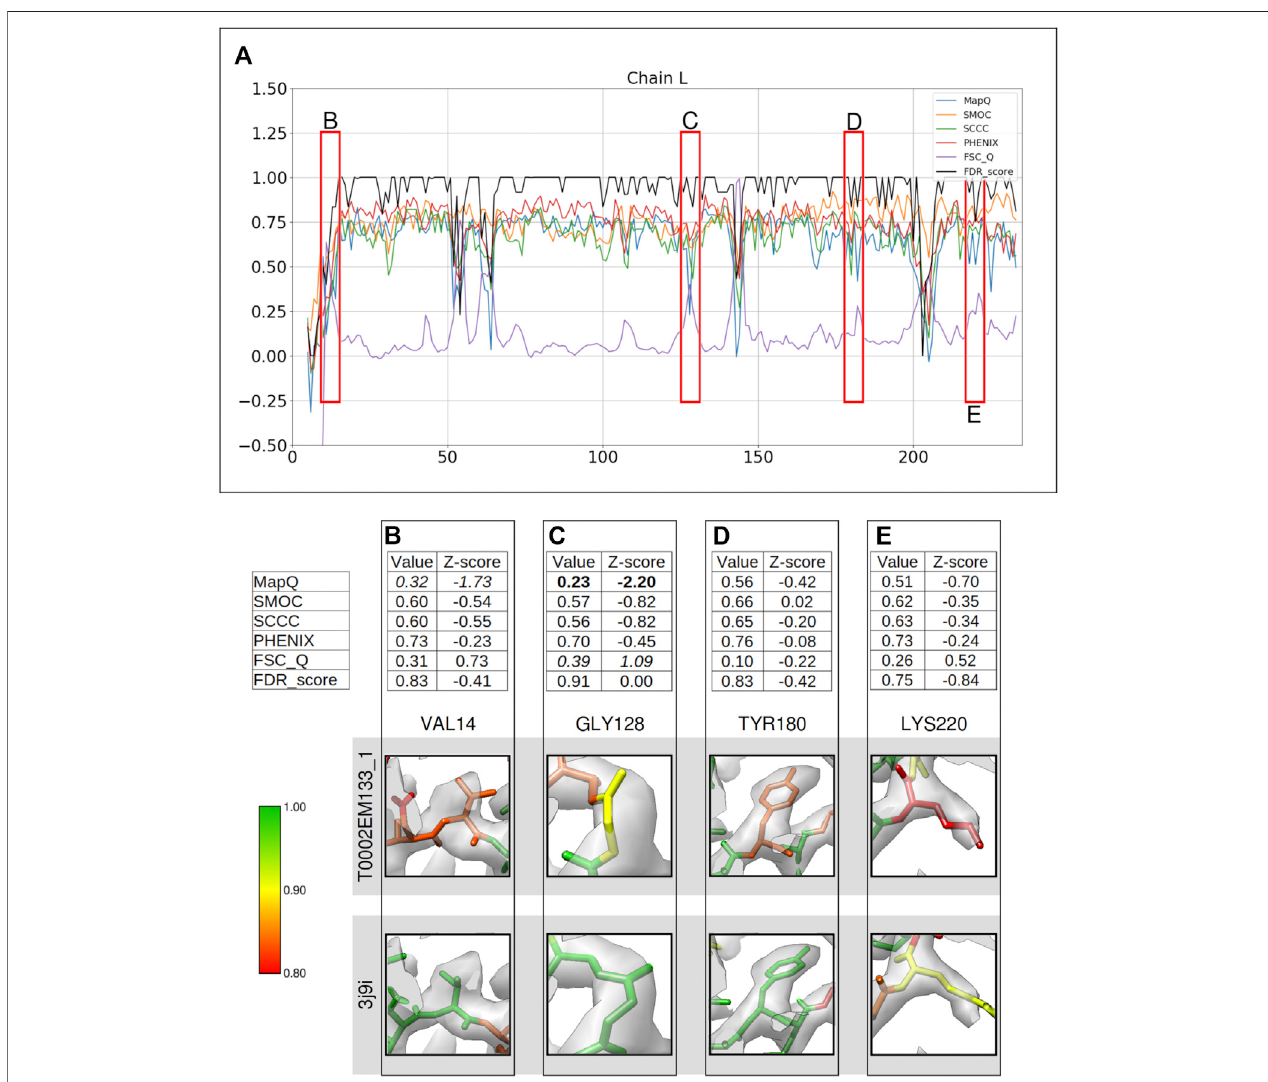
FIGURE 3 | Comparison of metrics for the atomic model of T20s proteasome, calculated only for the backbone atoms. (A) Comparison of the per-residue scores from MapQ, SMOC, SCCC, PHENIX, FSC-Q, and FDR backbone score for the chain L of the atomic model T0002EM133_1 from the EMDB model; the red boxes highlight the residues selected for detailed analysis in the panels below. For Val 14 (B) , Gly 128 (C) , Tyr 180 (D), and Lys 220 (E) , the panel shows a table with values of scores obtained with each metric and corresponding Z-scores; the residue fi t in the target map (EMD-6287, grey) displayed at the recommended contour level 0.025 (3.3 σ ) and rendered in UCSF Chimera; and the residue fi t in map as modeled in the reference (PDB ID: